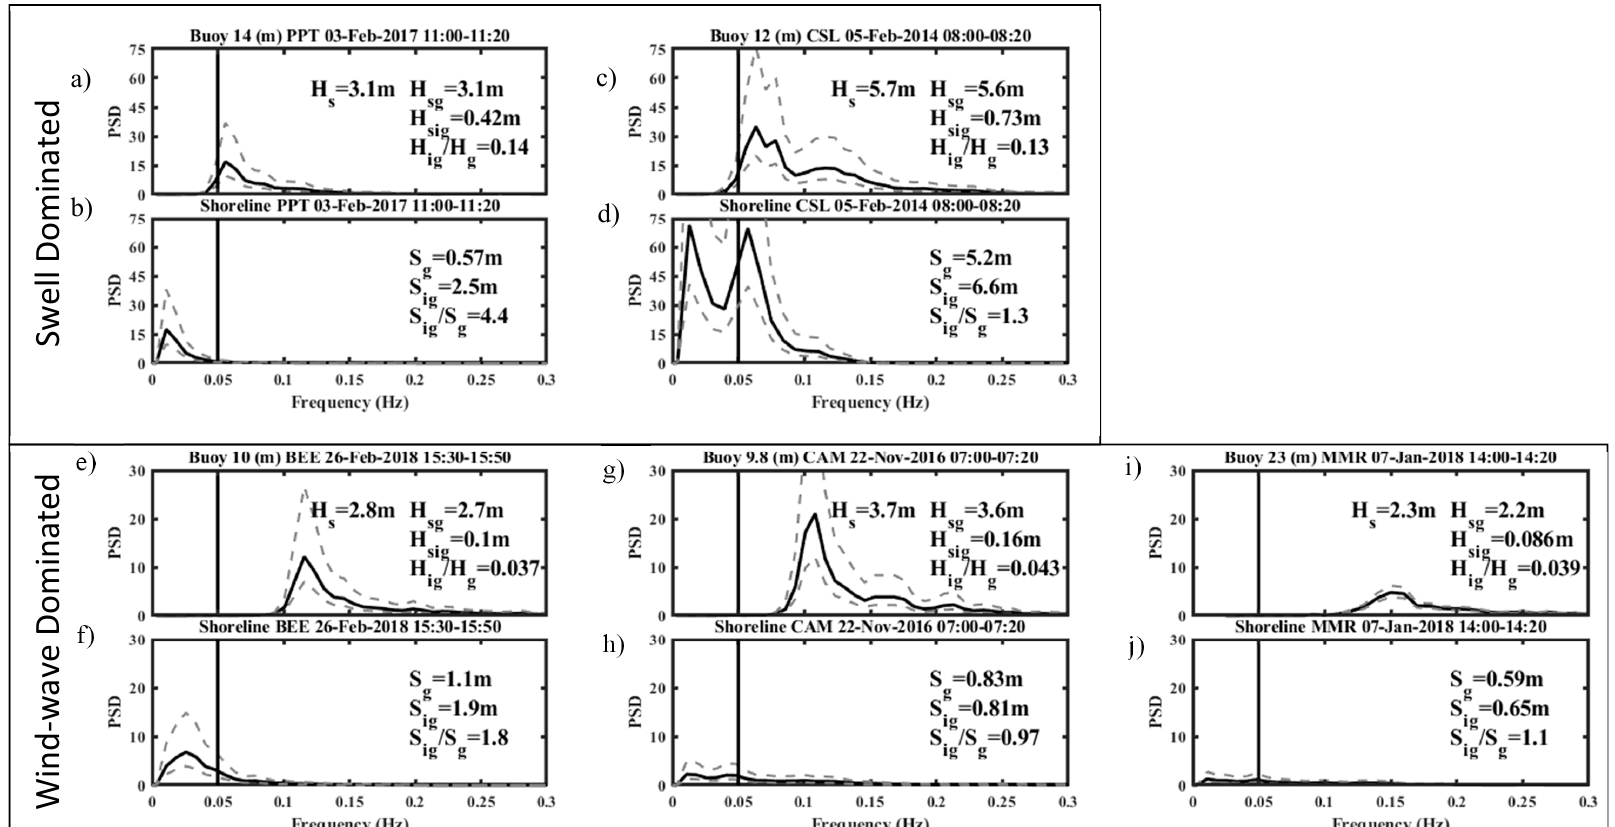
Figure 4. Frequency smoothed wave spectra showing examples of simultaneous power spectral densities (PSD) offshore and at the shoreline. a,c,e,g and i: Waves measured at local wave buoys (solid black line). b,d,f,h and j: Vertical swash at the shoreline (solid black line). Both: 95% confidence interval (dashed grey line). Infragravity and gravity bands are separated by a vertical black line at 0.05 Hz. a + b = Perranporth (PPT), c + d = Chesil (CSL), e + f Beesands = (BEE), g + h = Camber (CAM), i + j = Minsmere (MMR).